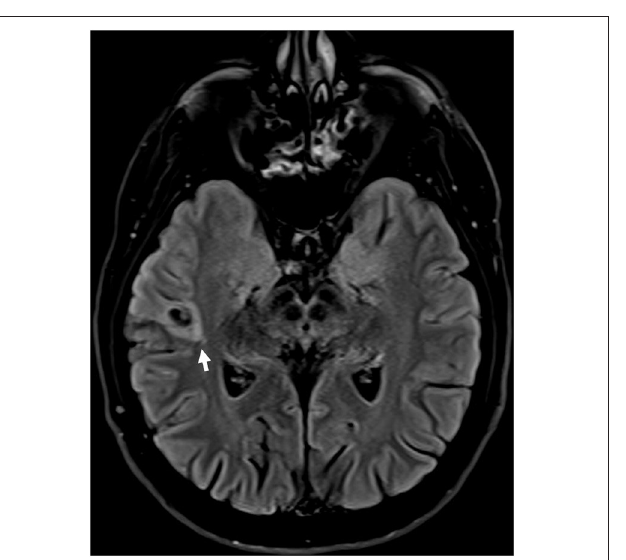
FIGURE 2 | Brain MRI (FLAIR; axial view) in a patient with drug-resistant epilepsy with auditory features showed a small hyperintense lesion in the right lateral temporal cortex surrounded by an area of signal suppression and hyperintensity of the adjacent brain tissue, consistent with a glioneuronal